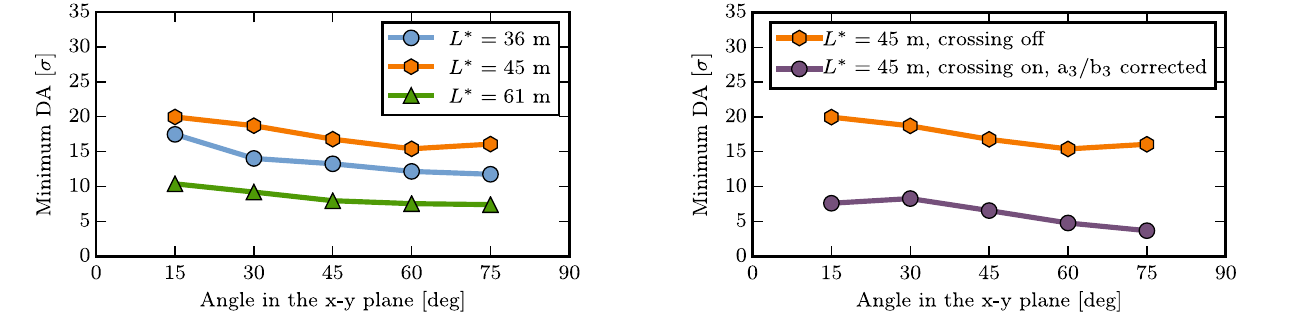
FIG. 19. Minimum dynamic apertures for the L (cid:2) ¼ 45 m lattice with β (cid:2) ¼ 0 . 3 m.